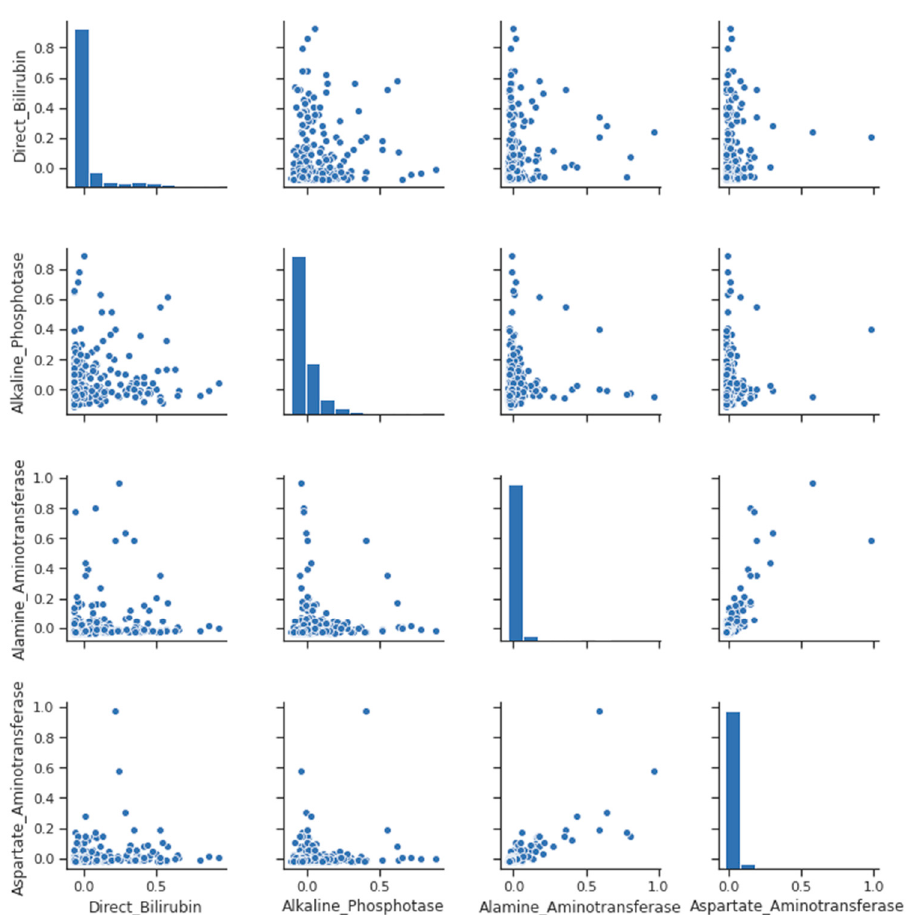
Figure 2. Pair Plot- liver disease.